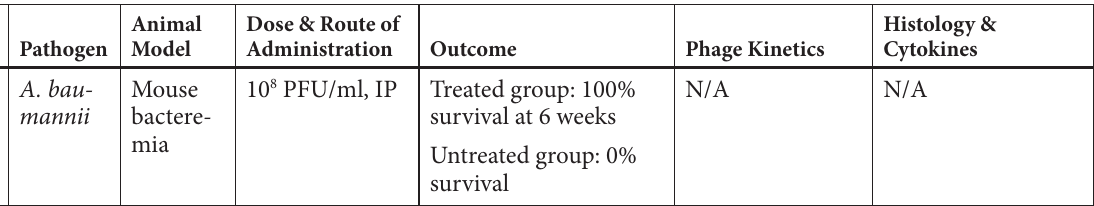
Table 2. Animal Bacteremia